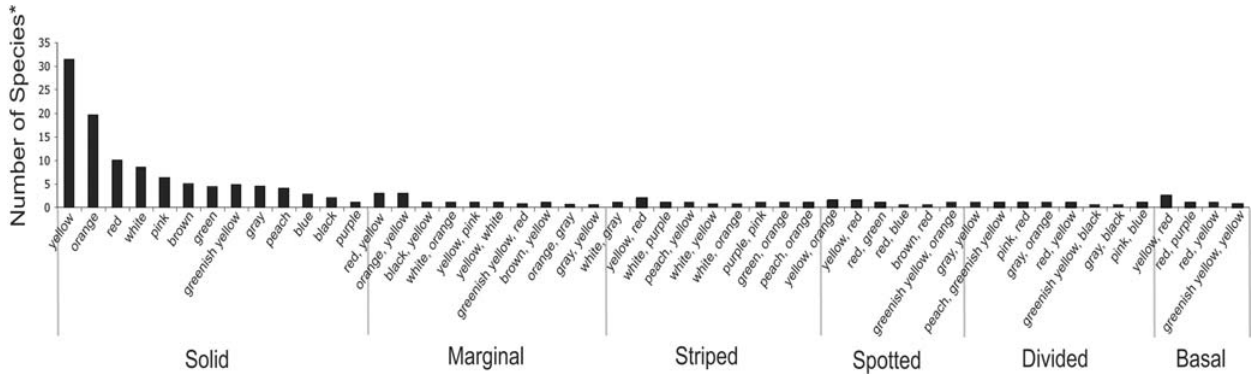
Figure 4. A histogram depicting the frequency of dewlap pattern and color combinations. *Data were weighted by the proportion of polymorphism exhibited by each species. For example, if a species exhibited four dewlap morphs and one was a solid yellow dewlap, a score of 0.25 was recorded for the solid yellow dewlap category.